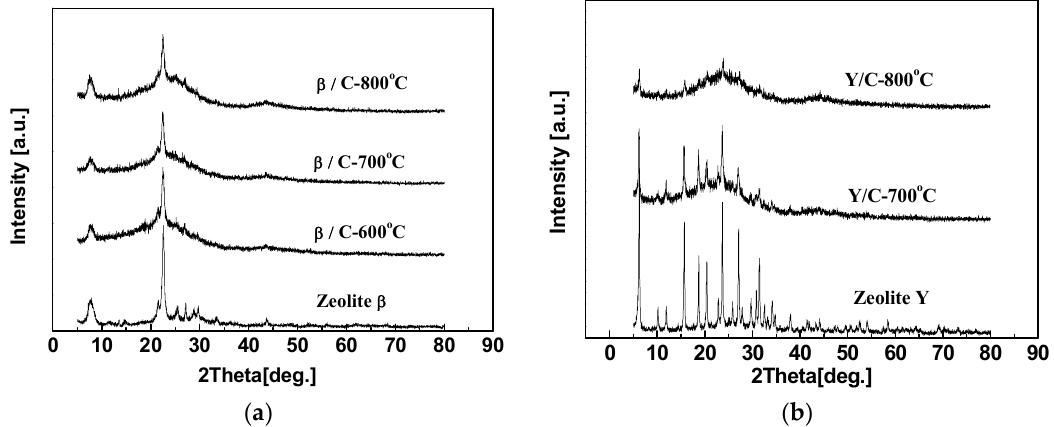
Figure 14. XRD patterns of zeolite β/C ( a ) and Y/C ( b ) hybrid membranes prepared at different pyrolysis temperatures [59].